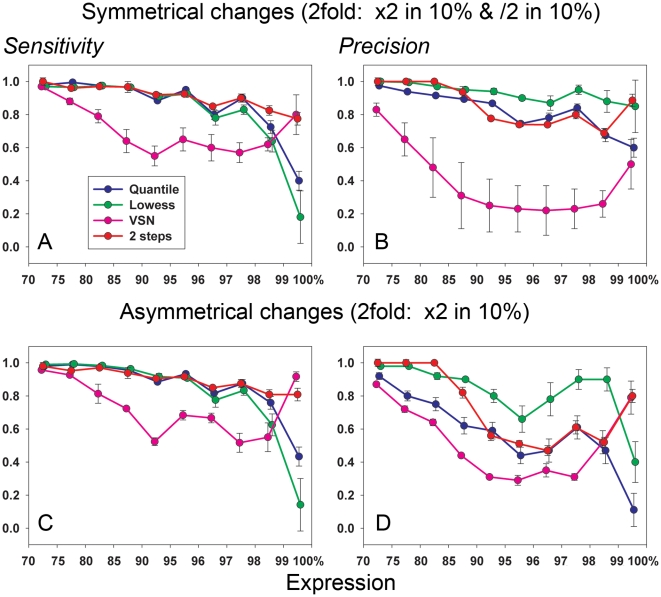
Comparison of normalization methods.The dataset was split into two equal subgroups, one of which remains unchanged and is used as a standard for comparison. The second subgroup is altered by introduced fold changes in the portion of gene expression. Four different normalizations were applied to the resulting data: Two-step normalization, Quantile, Lowess, and VSN. Associative analysis (see Materials and Methods) was used for the selection of differentially expressed genes with Fd/Fa/Em = 2/1.5/20 restrictions in all these cases. The procedure was repeated three times (every time with different arbitrary split of 20 samples data into 10&10 samples subgroups) and the averages and SD of the estimations are shown. A) Sensitivity and B) Precision (Y axes) for symmetrical changes in gene expression (2-fold increase in 10% and 2-fold decrease in another 10% of data). C) Sensitivity and D) Precision for asymmetric changes in gene expression (2-fold increases in 10% of gene expressions only). X axis shows the positions of the blocks of gene expression data used for the parameters estimations (in percentage along decreasingly sorted data, i.e. the 99–100 interval presents 1% of the genes with the highest expressions in the array).